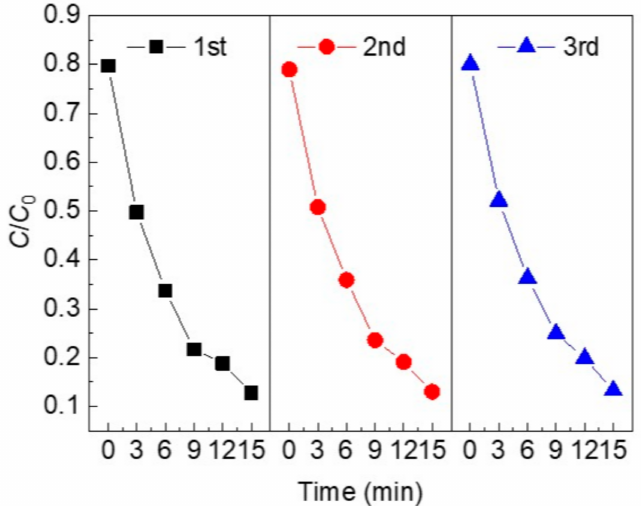
Figure 4. Photocatalytic stability test of CdS NPs in recycling